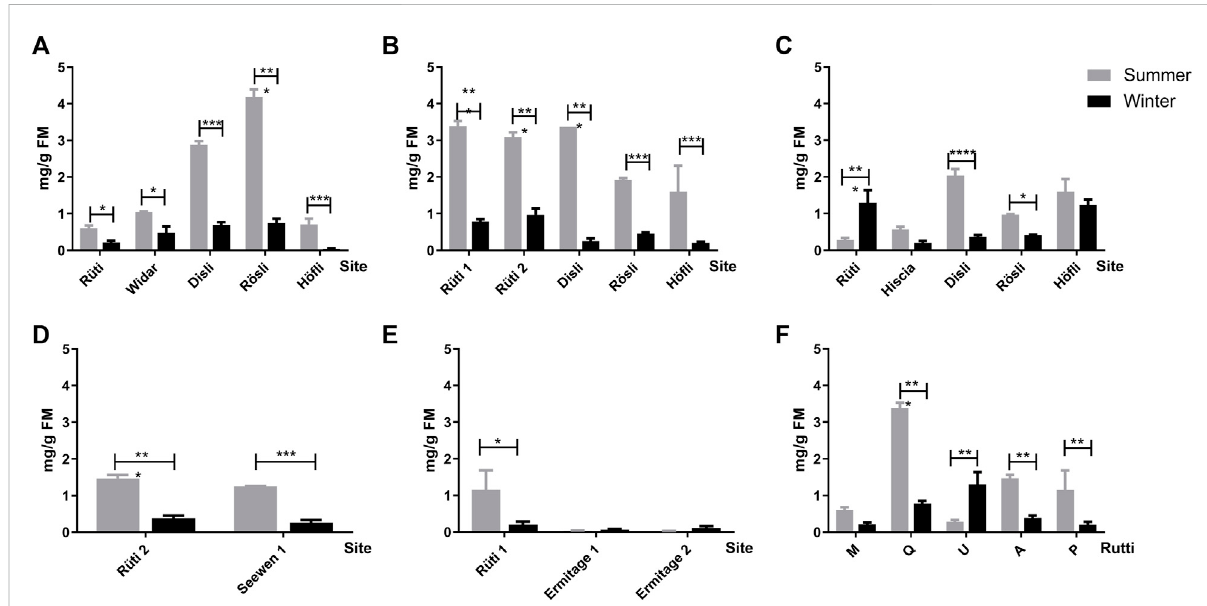
FIGURE 6 Amount of viscotoxin in mg/g of fresh material (FM) of V. album mother tinctures prepared with plants harvested in summer (grey bars) and in winter (black bars), in the following locations: Rütti, Widar, Disli, Rösli, Hö fl i, Hiscia, Seewen, Ermitage. MTs were prepared with mistletoe collected from the following host trees: Malus domestica . (A) Quercus sp. (B) Ulmus carpinifolia . (C) Abies alba . (D) and Pinus sylvestris (E) . Comparison of the viscotoxin content from the different host trees in the same location, Rüti. (F) The numbers added to Rütti and Ermitage locations represent